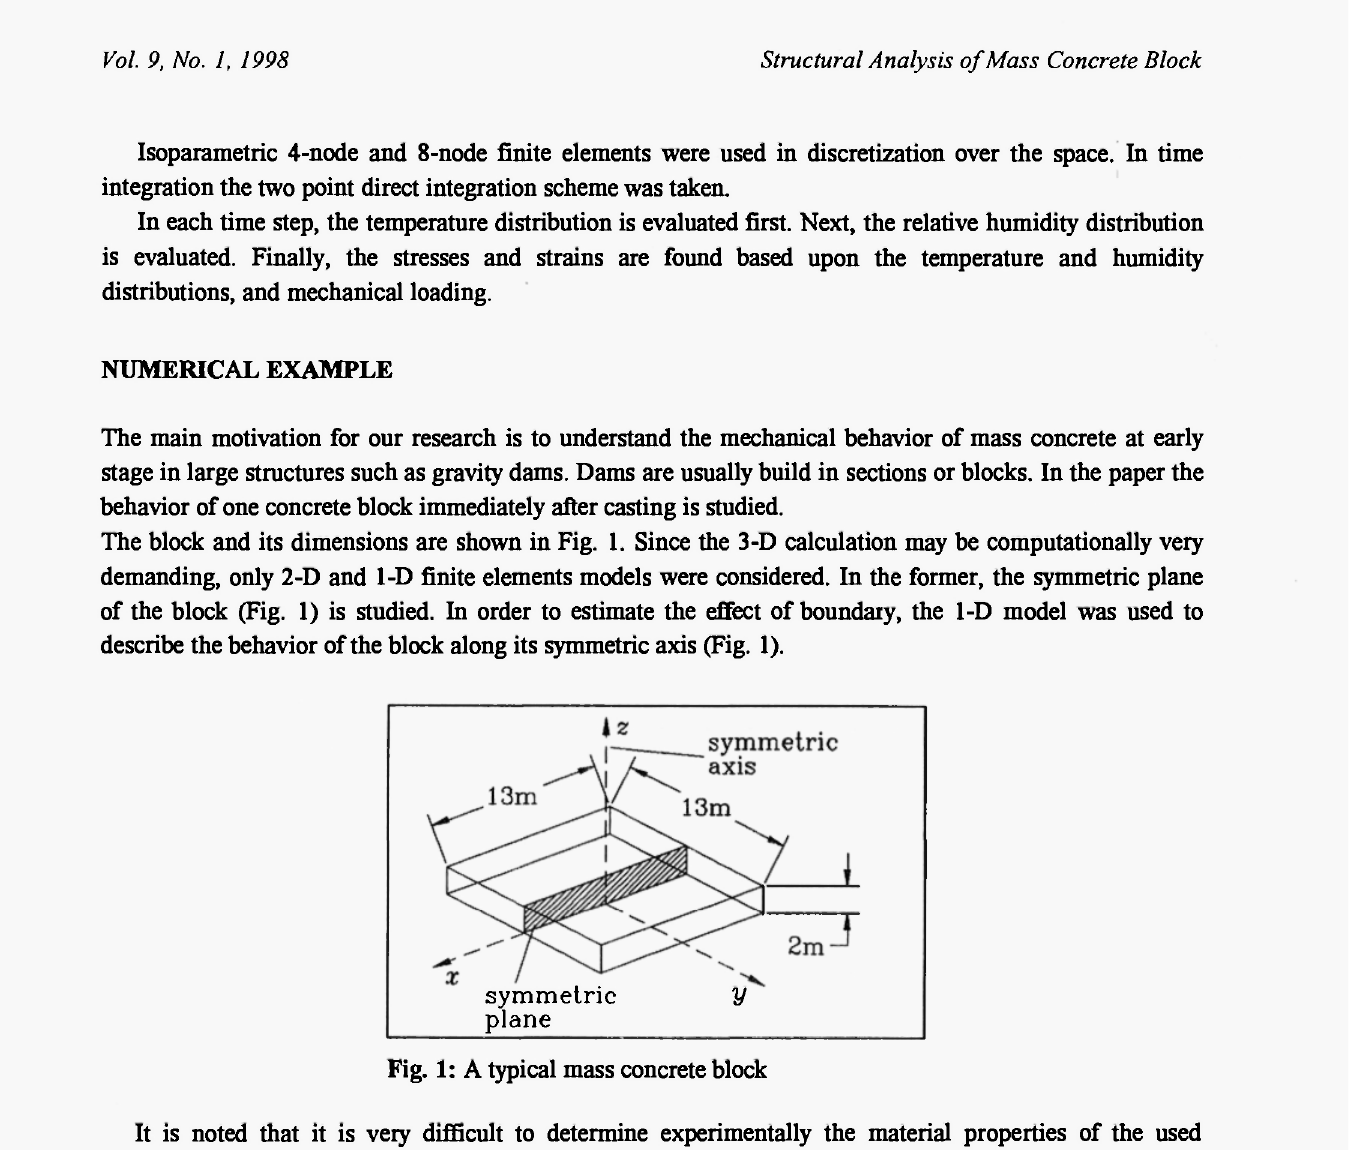
Fig. 1: A typical mass concrete